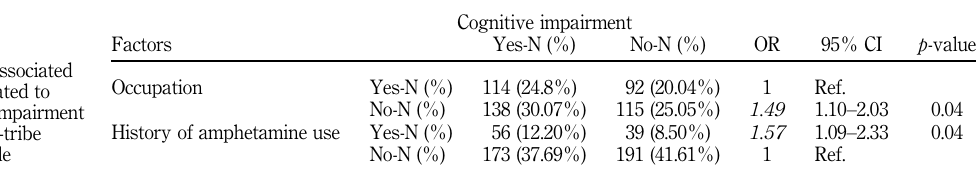
Table II. Potential associated factors related to cognitive impairment among hill-tribe older